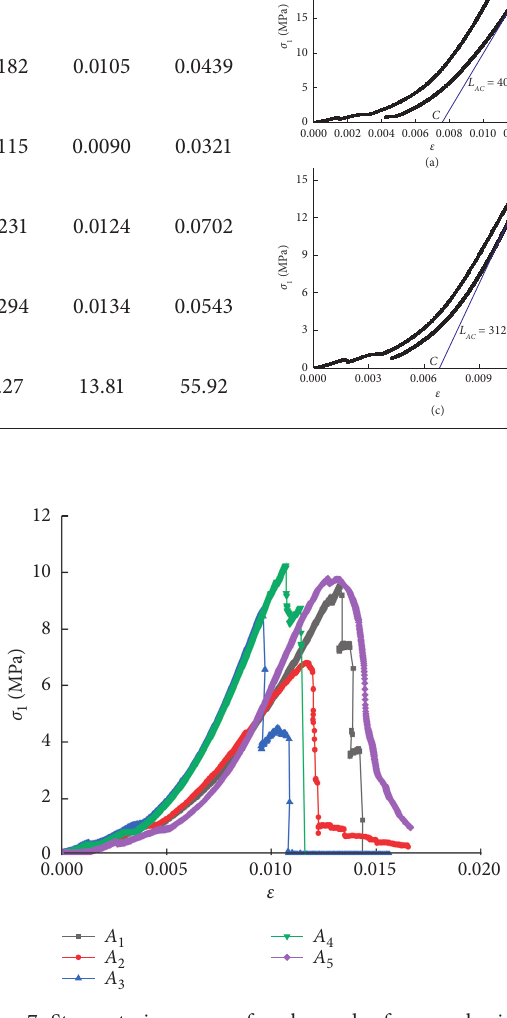
Figure 7: Stress-strain curves of coal samples from coal mine